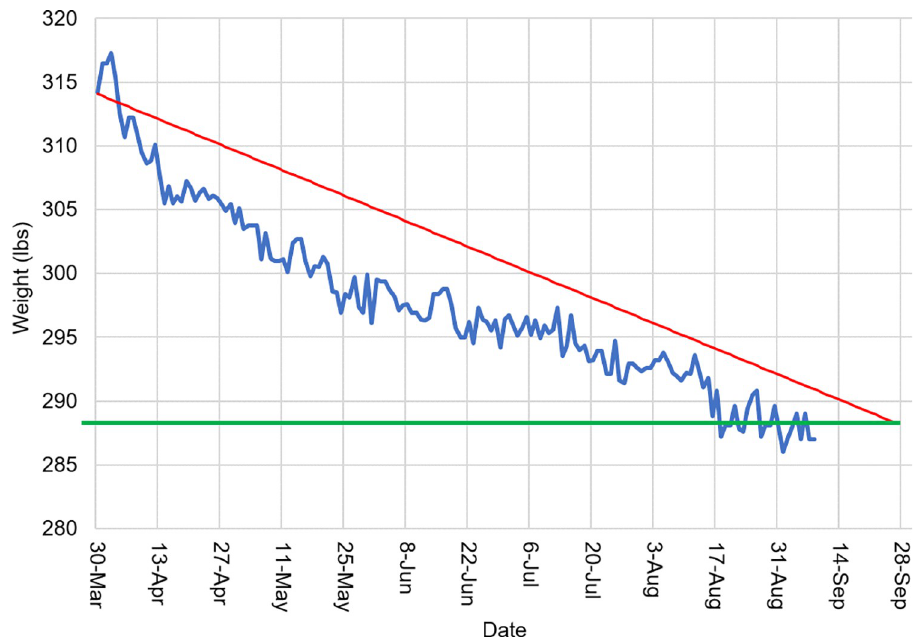
Fig 3. A weekly weight chart feedback. The red line represents the target weight loss slope (1 lb. loss (0.45 kg) per week) over time, the blue line represents actual daily weights, and the green line represents the target of 25 lbs. (11.3 kg) weight loss (based on a six month weight loss goal of 1 lb. (0.45 kg) loss per